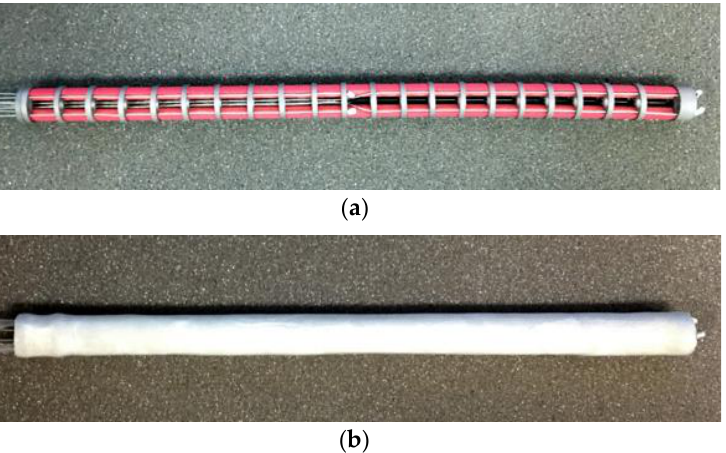
Figure 4. Prototype of the designed variable stiffness endoscopic manipulator: ( a ) inner continuum stiffness-adjusting mechanism; ( b ) overview of the fabricated endoscopic